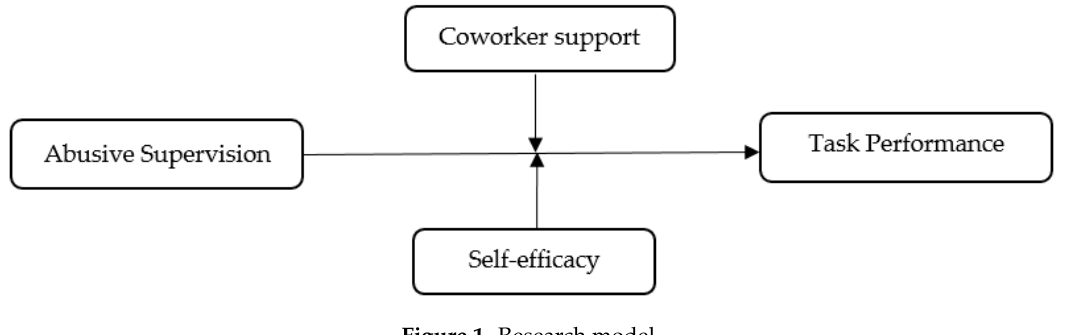
Figure 1. Research model.